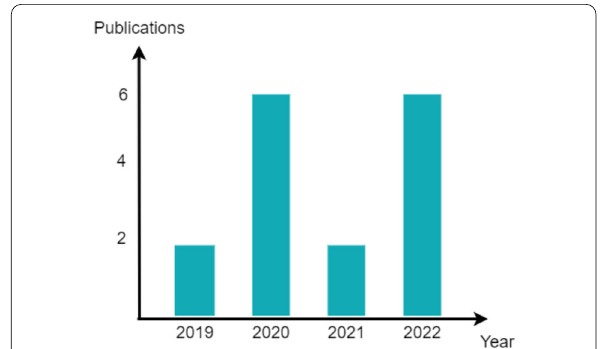
Figure 1 Distribution of the reviewed papers